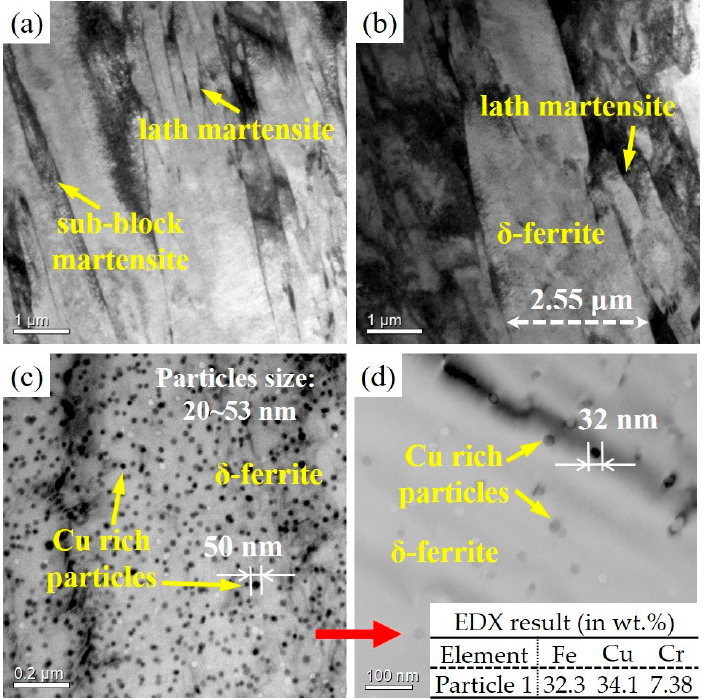
Figure 4. Bright-field image of ( a ) lath martensite and sub-block martensite, ( b ) δ -ferrite in 17-4 PH SS after homogenization. ( c ) Many fine Cu-rich nanoparticles existed in the δ -ferrite matrix. ( d ) EDX spectra of Cu-rich particles.